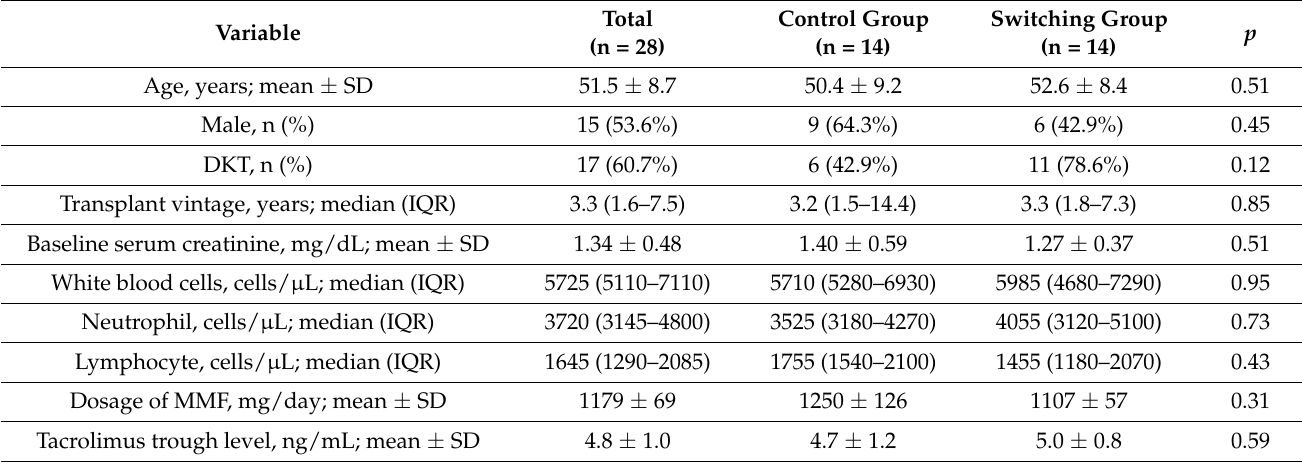
Figure 2. The anti-SARS-CoV-2 S antibody level (median [IQR]) pre- and post-fourth vaccination with BNT162b2 between the control group and the switching group. Baseline anti-SARS-CoV-2 S